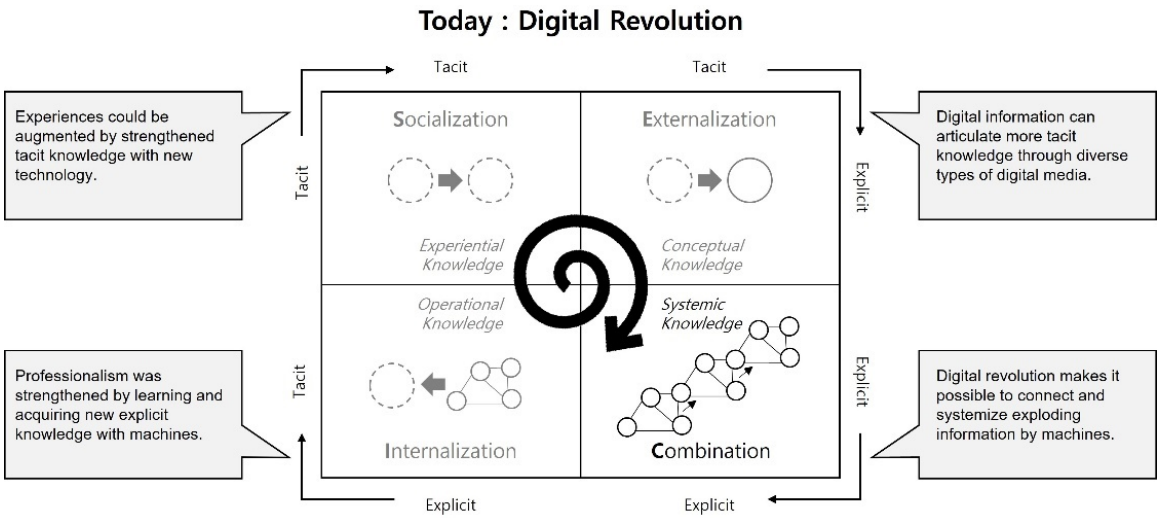
Figure 6. SECI Model Today.